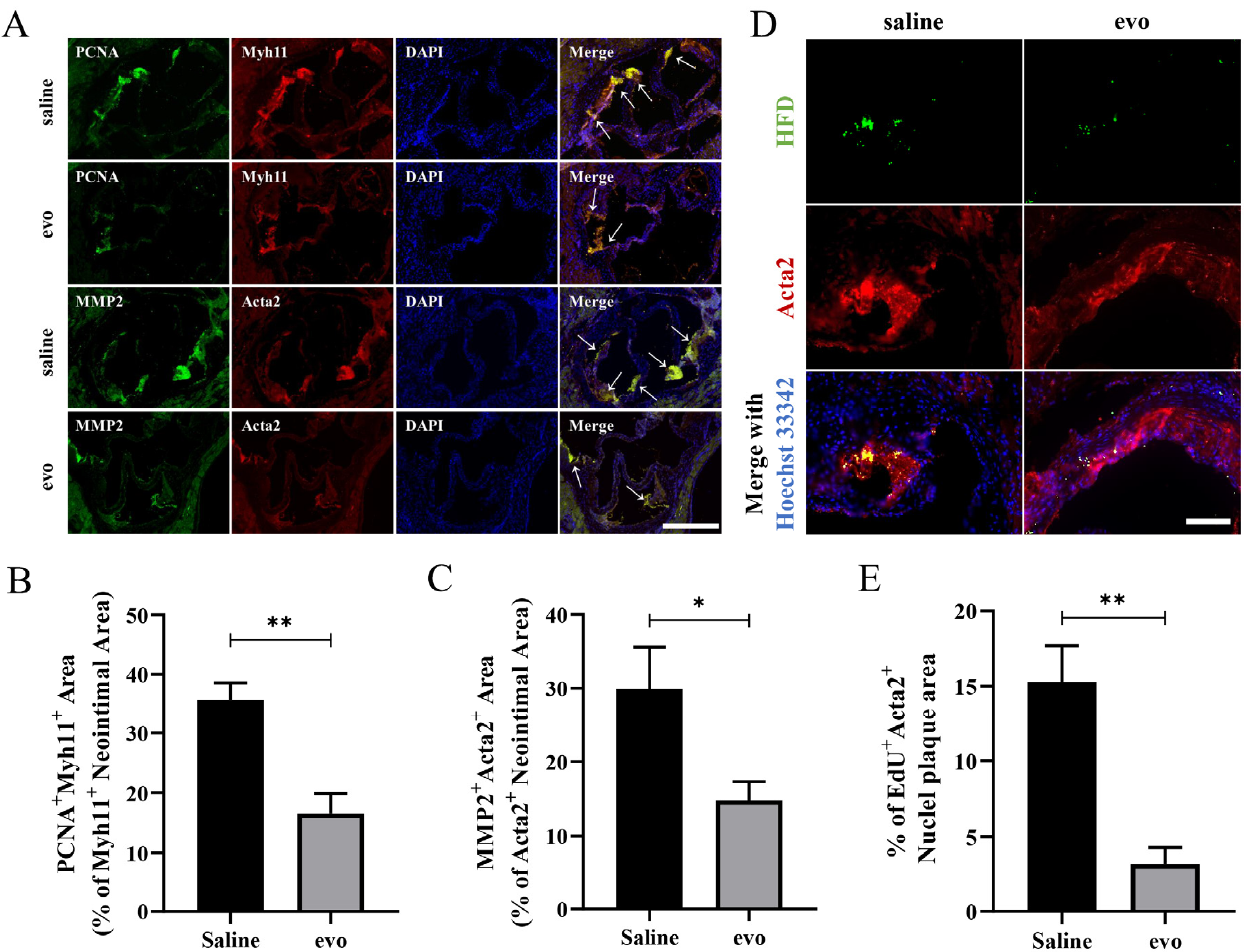
Figure 2. Analysis of proliferation and migration of atherosclerotic VSMCs in mice: ( A – C ) the transverse section of the aortic root was analyzed and quantified by immunofluorescence staining. PCNA and MMP2 expression in atherosclerotic plaques (green). Immunofluorescence shows that Myh11 (red) co-express PCNA and Acta2 (red) co-express MMP2 within the atherosclerotic lesion. The white arrow points to the co-stained area. Scale bar 500 µ m. ( D , E ) Representative EdU staining and quantification of proliferating cells in plaques. Yellow fluorescence indicates EdU + Acta2 + cells. Scale bar 100 µ m. The bar graphs depict means ± SEM; statistical significance * p < 0.05 and ** p < 0.01 by the one-way ANOVA test.